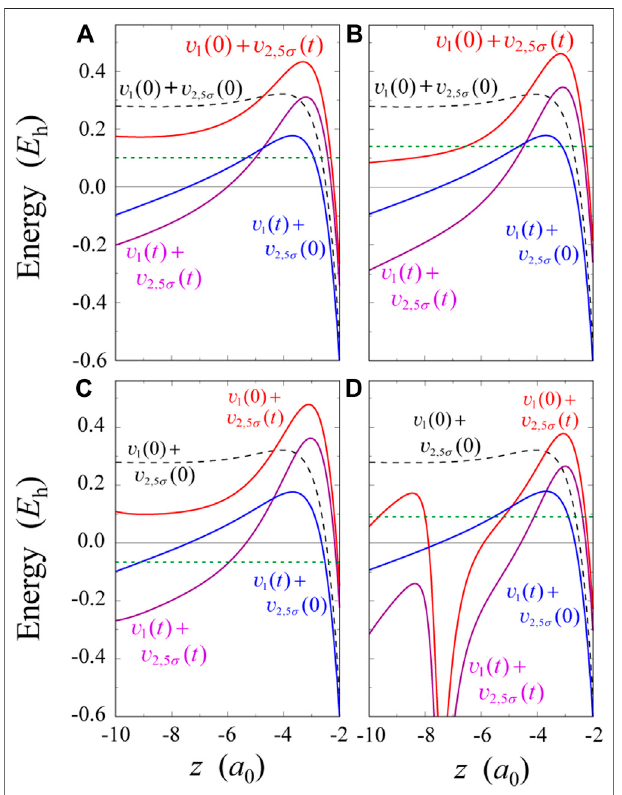
FIGURE 4 | Four kinds of 5 σ effective potentials plotted parallel to the z -axis at the fi xed value of ρ (cid:2) 0.755 a 0 . The pulses used in four panels (A – D) correspond to those in Figure 3(A – D) , respectively. υ 1 ( t ) and υ 2 , 5 σ ( t ) are respectively the one-body part and two-body part in υ eff 5 σ ( t ) . The de fi nitions of effective potentials are designated in each panel. The effective potentials in these panels are all calculated by TD-CASSCF. The green horizontal dotted line denotes the effective orbital energy E 5 σ ( t ) . The time point at which the effective potentials are calculated is indicated by a red fi lled circle in each panel in Figure 3 .